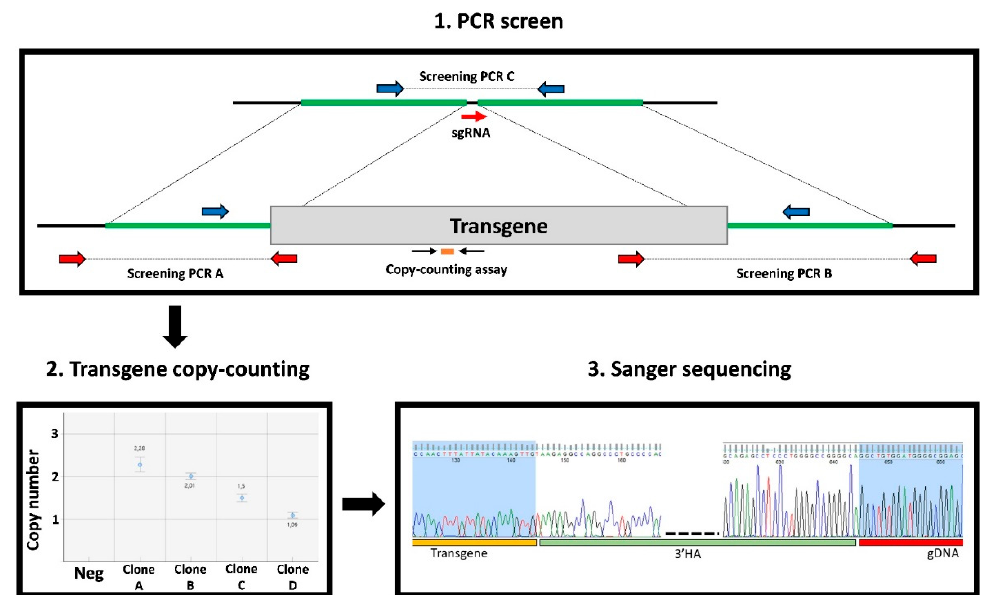
Figure 3. Screening strategies for large KI. Screening CRISPR-edited hPSC clones harboring large KI